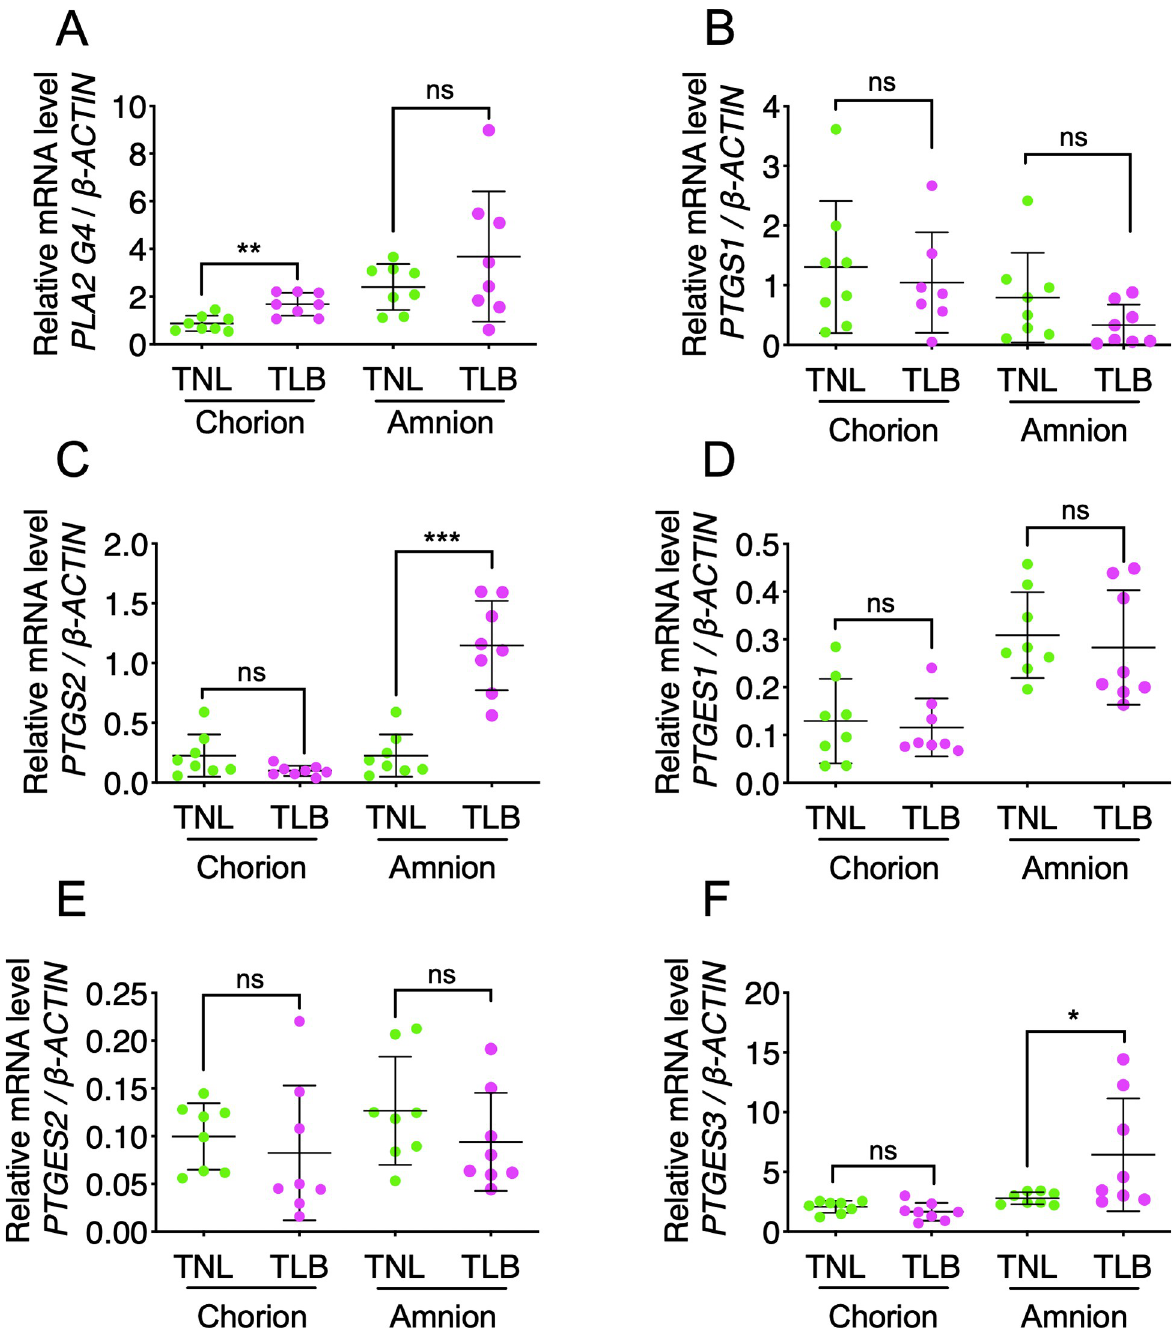
Fig 5. Expression of genes of the prostaglandin E 2 (PGE 2 ) biosynthetic enzymes in the amnion and the chorion. Relative levels of mRNAs encoding genes involved in PGE 2 biosynthesis in the amnion and the chorion of patients with term not in labor (TNL) or term in labor (TLB) deliveries were measured by RT-qPCR. (A) PLA2G4A , (B) PTGS1 , (C) PTGS2 , (D) PTGES1 , (E) PTGES2 , (F) PTGES3 . Horizontal lines and error bars indicate the mean ± SEM. TNL, n = 8; TLB, n = 8. Data were analyzed by unpaired Student’s t -tests. � p < 0.05, �� p < 0.01, ��� p < 0.005; ‘ns’, not